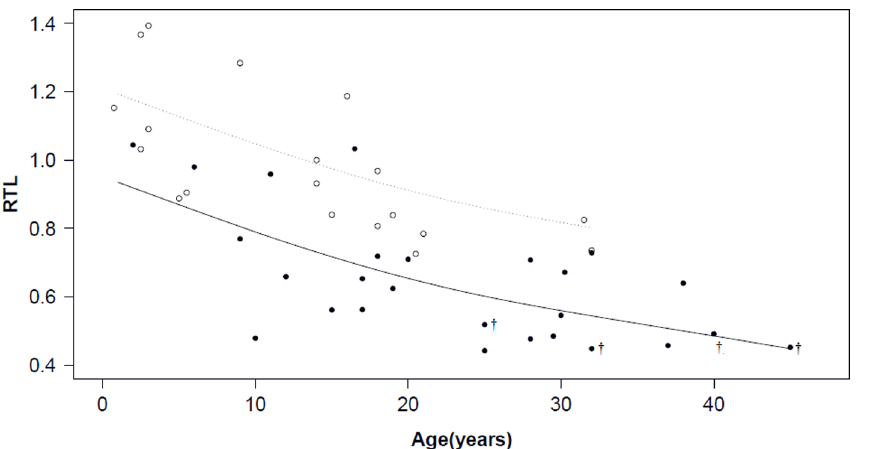
Figure 1. Relative telomere length (TL/non-NVC) and age for single-housed birds (filled circles) and pair-housed birds (open circles); Deviance explained 70.6%; { individuals that died during study period. The predicted RTLs are shown with a black line for single- housed birds and with a dashed line for pair-housed birds.